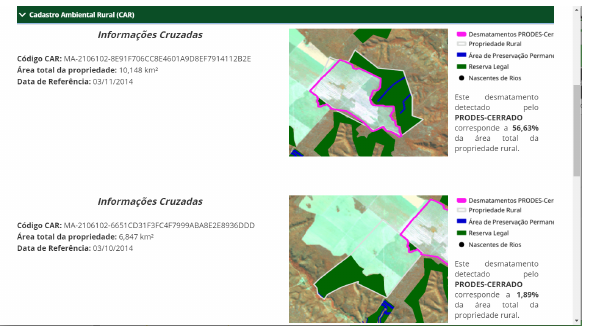
Figure 9. Deforestation Report presenting the spatial intersection of a selected deforestation polygon with the respective Rural Environmental Registry (CAR) displayed in the Deforestation Report, as shown in figure 10.